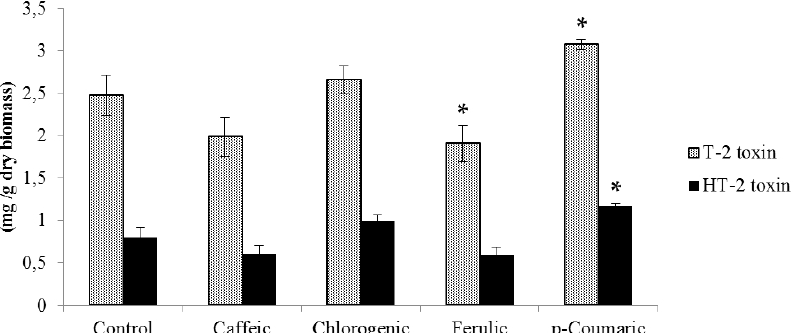
Figure 2. T ‐ 2 and HT ‐ 2 toxin production by F. sporotrichioides at 0.5 mM of each phenolic acid incubated at 25 °C for 14 days. Values expressed as mean values ± SD of three biological replications. The sign * indicates significant difference with respect to control according to t ‐ test ( p < 0.05).